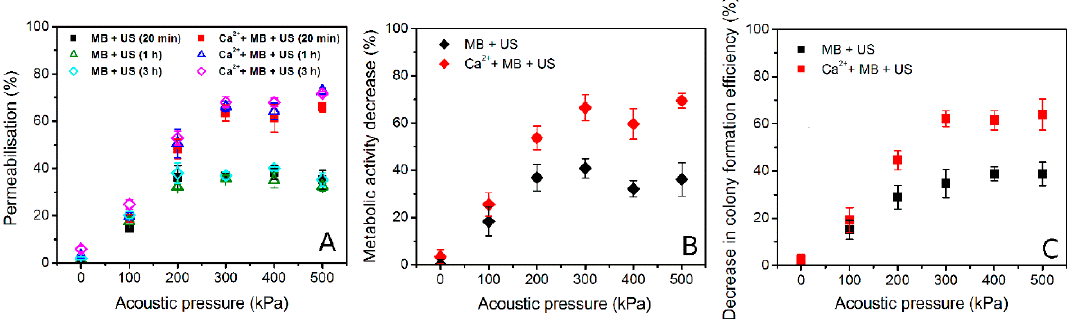
Figure 9. Cell membrane permeabilization ( A ), metabolic activity decrease ( B ) and decrease in cell colony formation efficiency ( C ), evaluated in cavitation (MB + US) and therapeutic (Ca 2+ + MB + US) groups at different acoustic pressure.